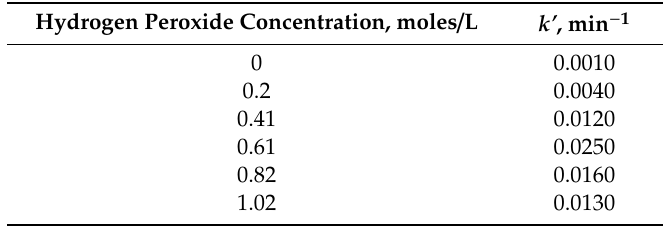
Table 2. Kinetic parameters of hydrogen peroxide concentration